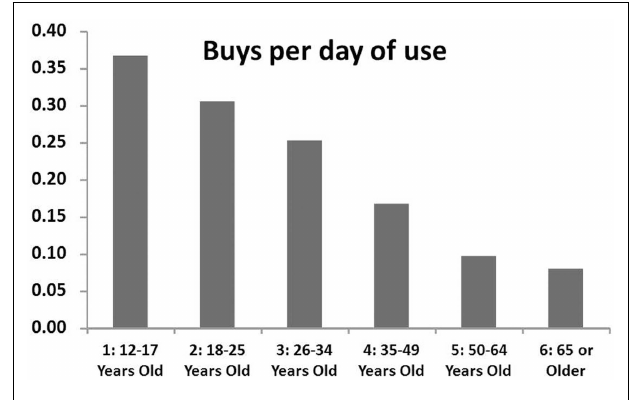
FIGURE 1 |The reported number of purchases per day of use varies dramatically with age in U.S. household survey data, 2011 NSDUH .